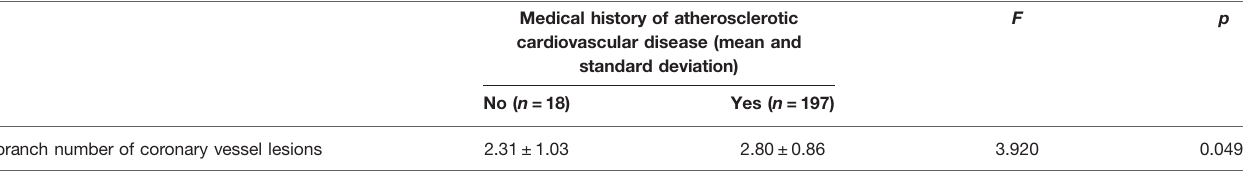
branch number of coronary vessel